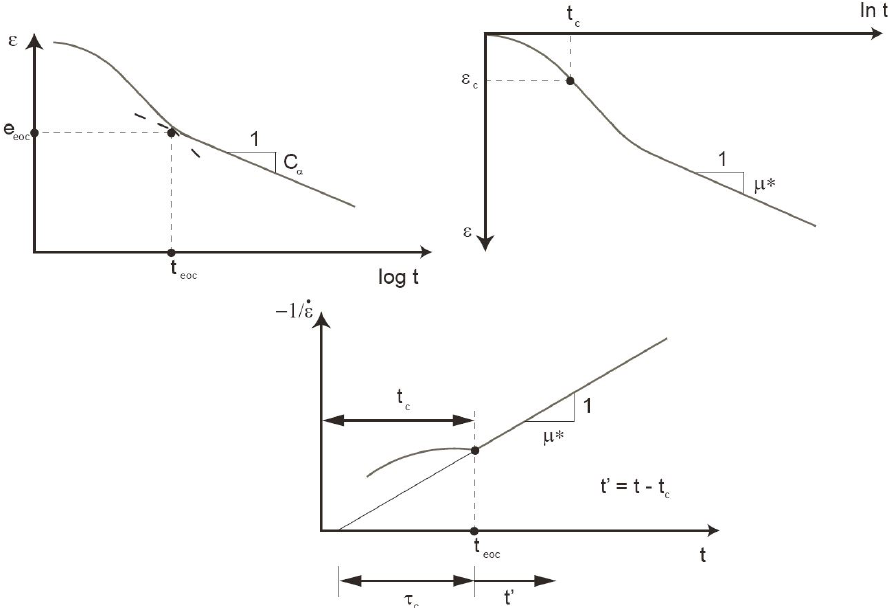
Figure 15: Determination of the creep index in oedometric conditions.